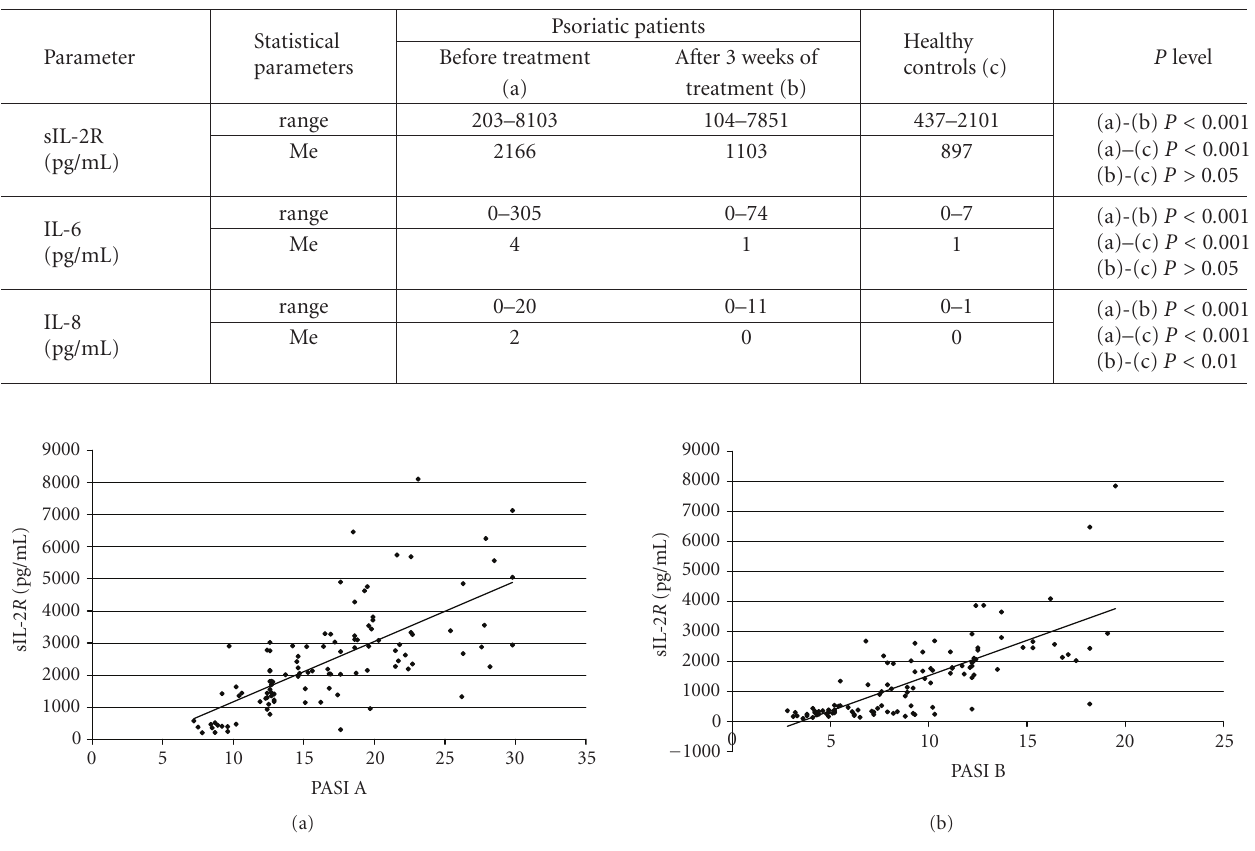
Figure 1: Correlation between sIL-2R plasma levels and PASI score before (PASI A) and after (PASI B) the treatment ( y represents linear regression equation; R 2 represents determination coe ffi cient): (a) PASI A, y = 187 . 77 x − 708 . 51, R 2 = 0 . 4725; (b) PASI B, y = 234 . 67 x − 814 . 12, R 2 = 0 .